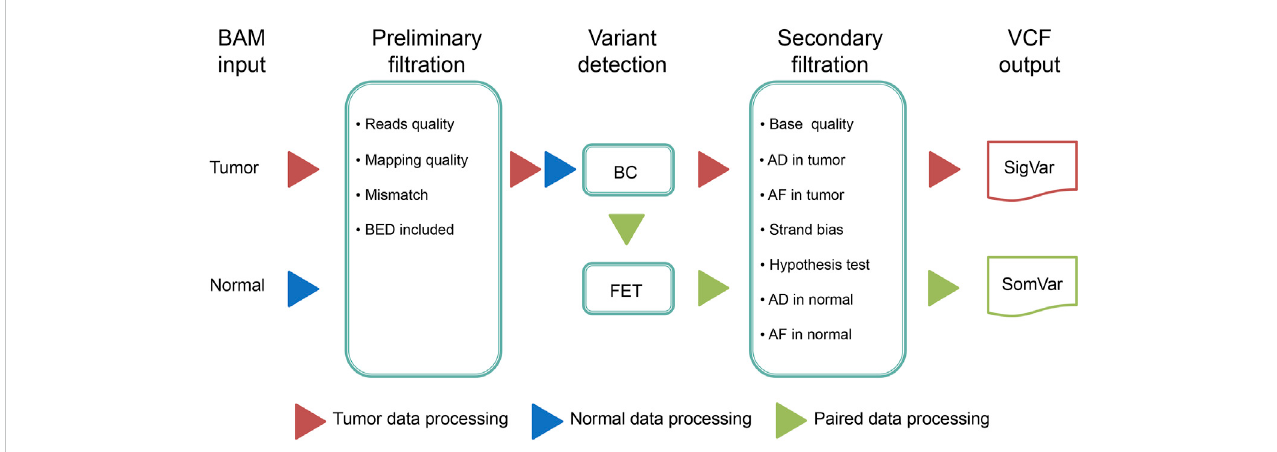
FIGURE 1 The work fl ow of DeteX. DeteX uses BAM format fi le as input. The preliminary fi ltering is mainly concerned with base quality and mapping quality. Then it applies Bayesian classi fi er (BC) method for mutation calling. For tumor-normal matched data, Fisher ’ s exact test (FET) is further performed to identify the candidate variant. By reducing false positive by meeting several screening criteria (Supplementary Table S1) the fi nal high-con fi dence variants is obtained. SigVar indicates single tumor variant and SomVar indicates somatic